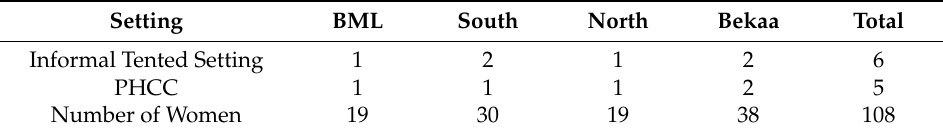
Table 1. Distribution of focus group discussions in all governorates of Lebanon by setting. Setting BML South North Bekaa Total Informal Tented Setting 1 2 1 2 6 PHCC 1 1 1 2